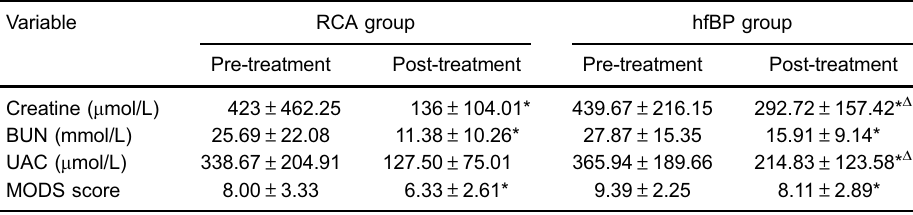
Table 5. Blood clearance parameters and multiple organ dysfunction syndrome (MODS) scores of regional citrate anticoagulation (RCA) and heparin-free blood puri fi cation (hfBP) treatment groups. Variable RCA group hfBP group